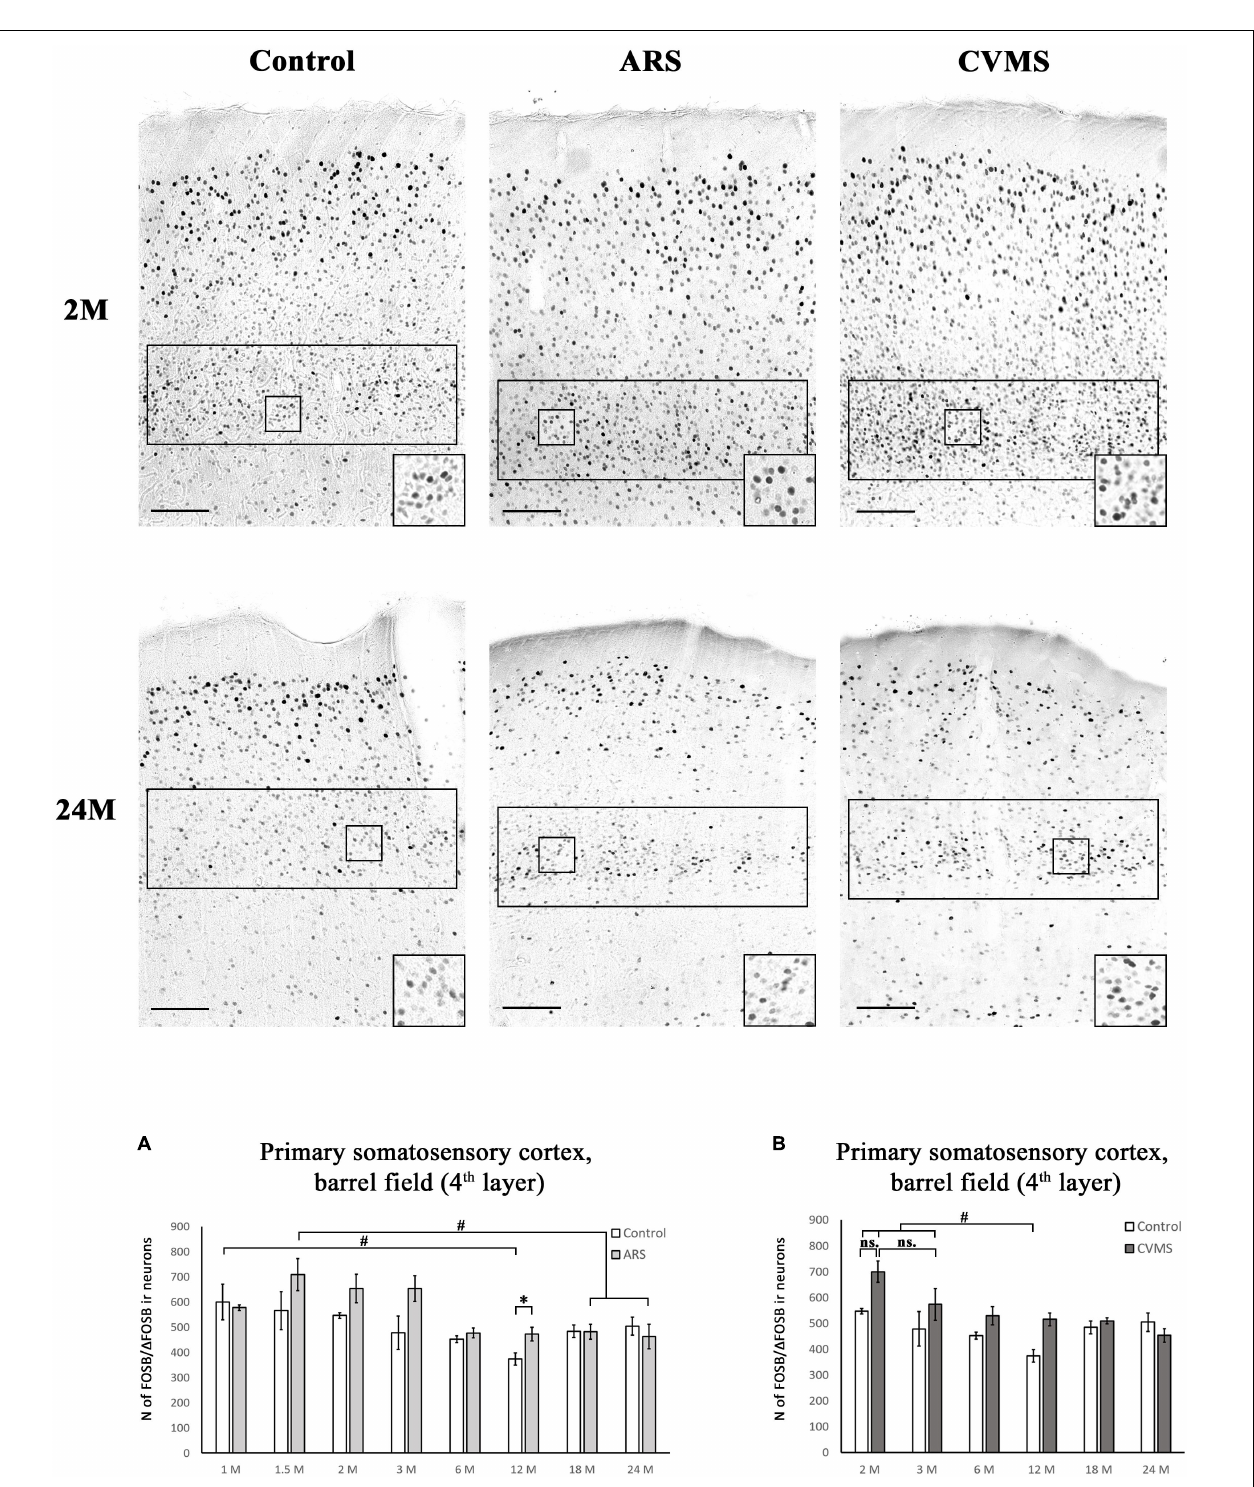
FIGURE 8 | Age-dependent FOSB/ (cid:49) FOSB immunoreactivity (IR) in the primary somatosensory cortex, barrel field (S1). We examined the cell density of the 4th cortical layer at –3.12 mm to the Bregma. The images represent the S1 in 2- and 24-month-old (M) control, acute restraint stress (ARS)-, and chronic variable mild stress (CVMS)-exposed rats. The number of FOSB/ (cid:49) FOSB IR nuclei was compared among eight or six age groups in histogram (A) for ARS model, and (B) for the CVMS model. Open bars represent the control groups; light gray columns refer to ARS-exposed rats; the dark gray columns indicate the CVMS-exposed animals ( N = 4–7). # p < 0.05, ## p < 0.01, (ns, insignificant) according to Tukey’s post-hoc test. ∗ p < 0.05, ∗∗ p < 0.01 according to t -tests. Scale bar: 100 µ